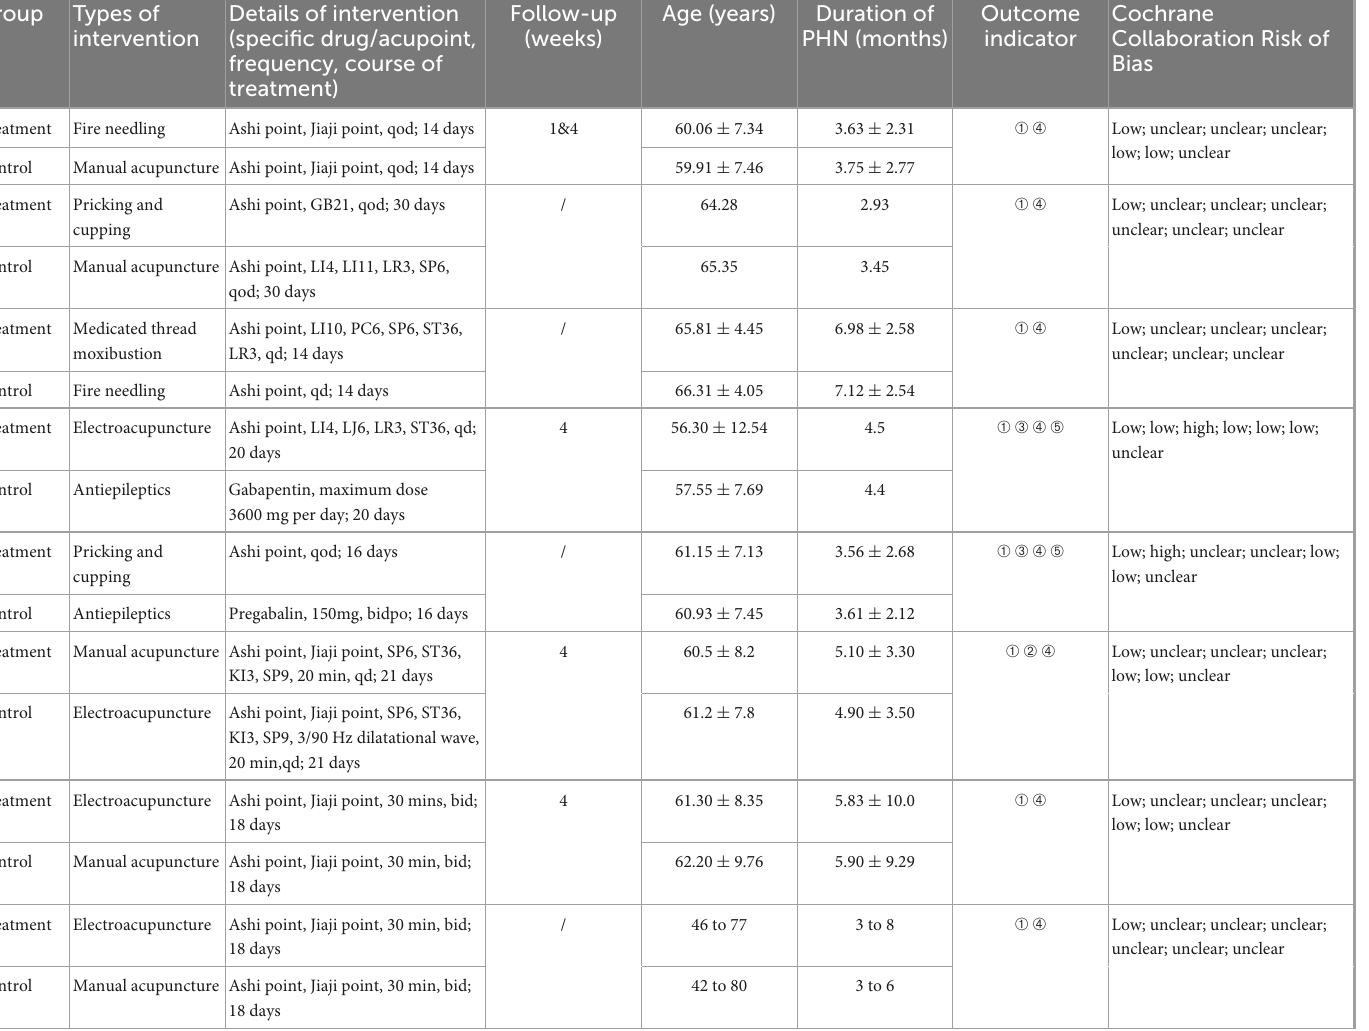
TABLE 2 Characteristics of the included